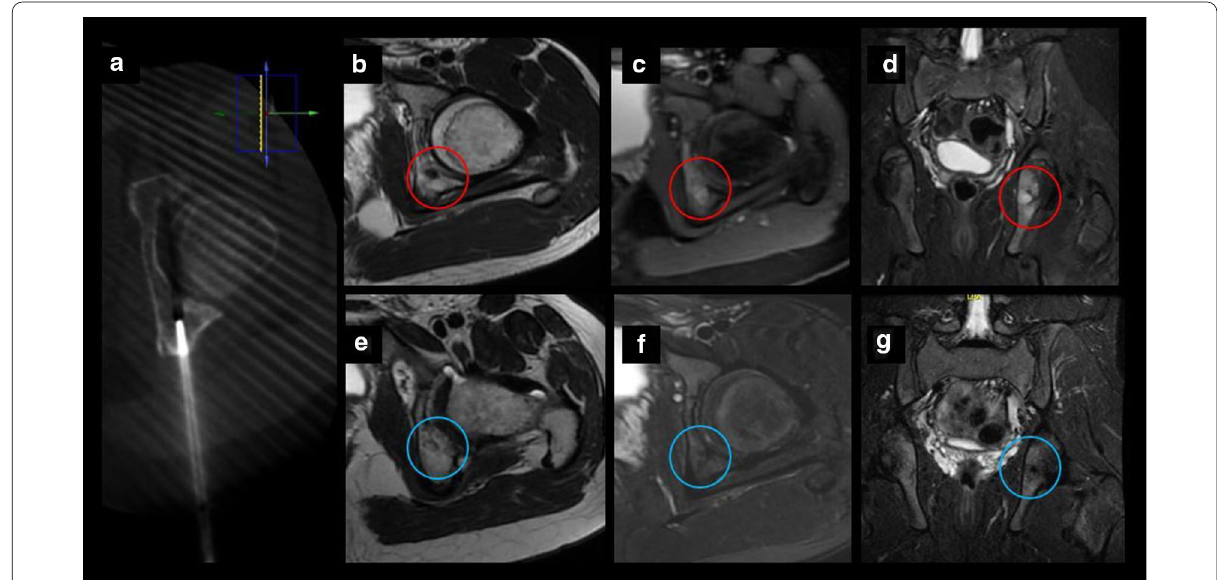
Fig. 6 Chondroblastoma in a 14‑y.o patient. a Axial CT exhibiting one cryoprobe placed within the lesion. b–d MRI images demonstrating a small tumor in the left posterior acetabulum corresponding to chondroblastoma (red circle). e–g Follow‑up MRI images 20 months after treatment with no evidence of recurrence (blue